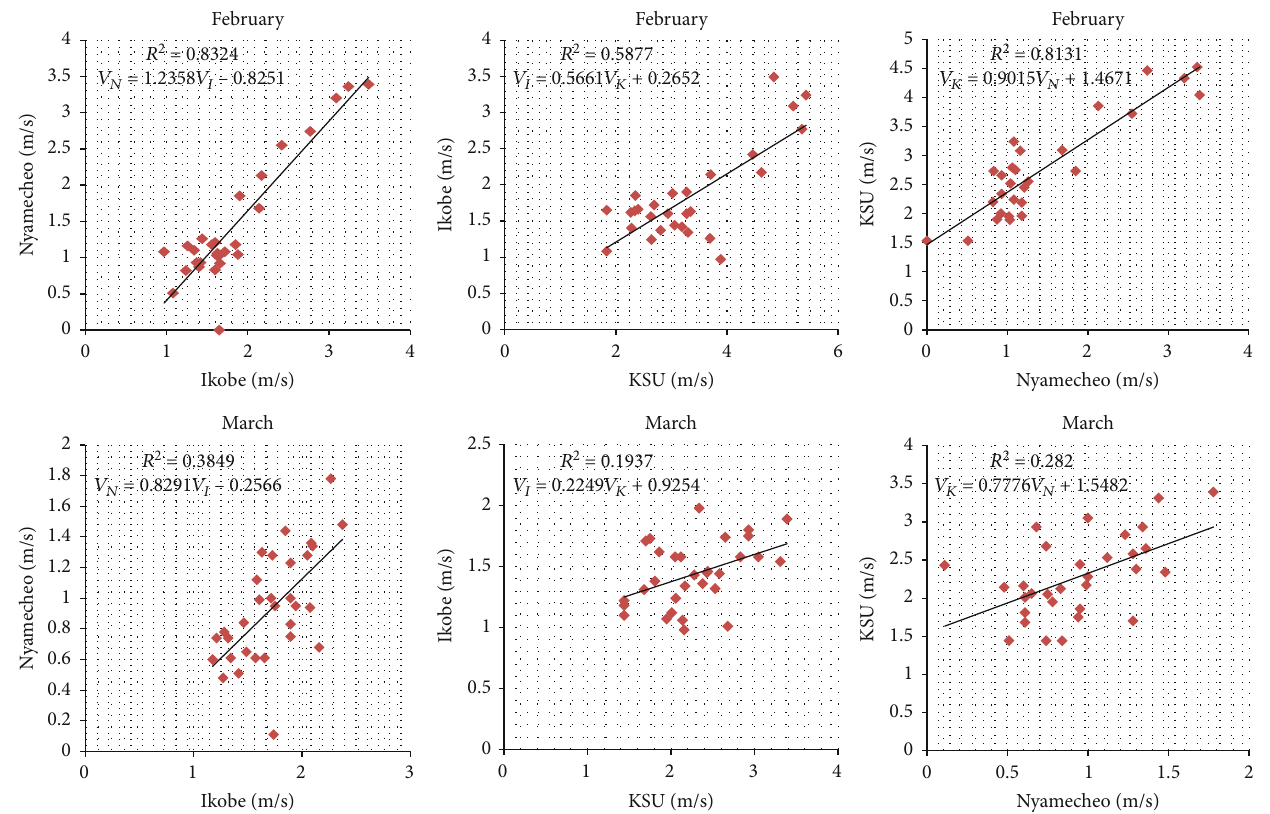
Figure 12: Correlation fi t scatter graphs, coe ffi cients, and prediction equations of the site ’ s wind pro fi les.